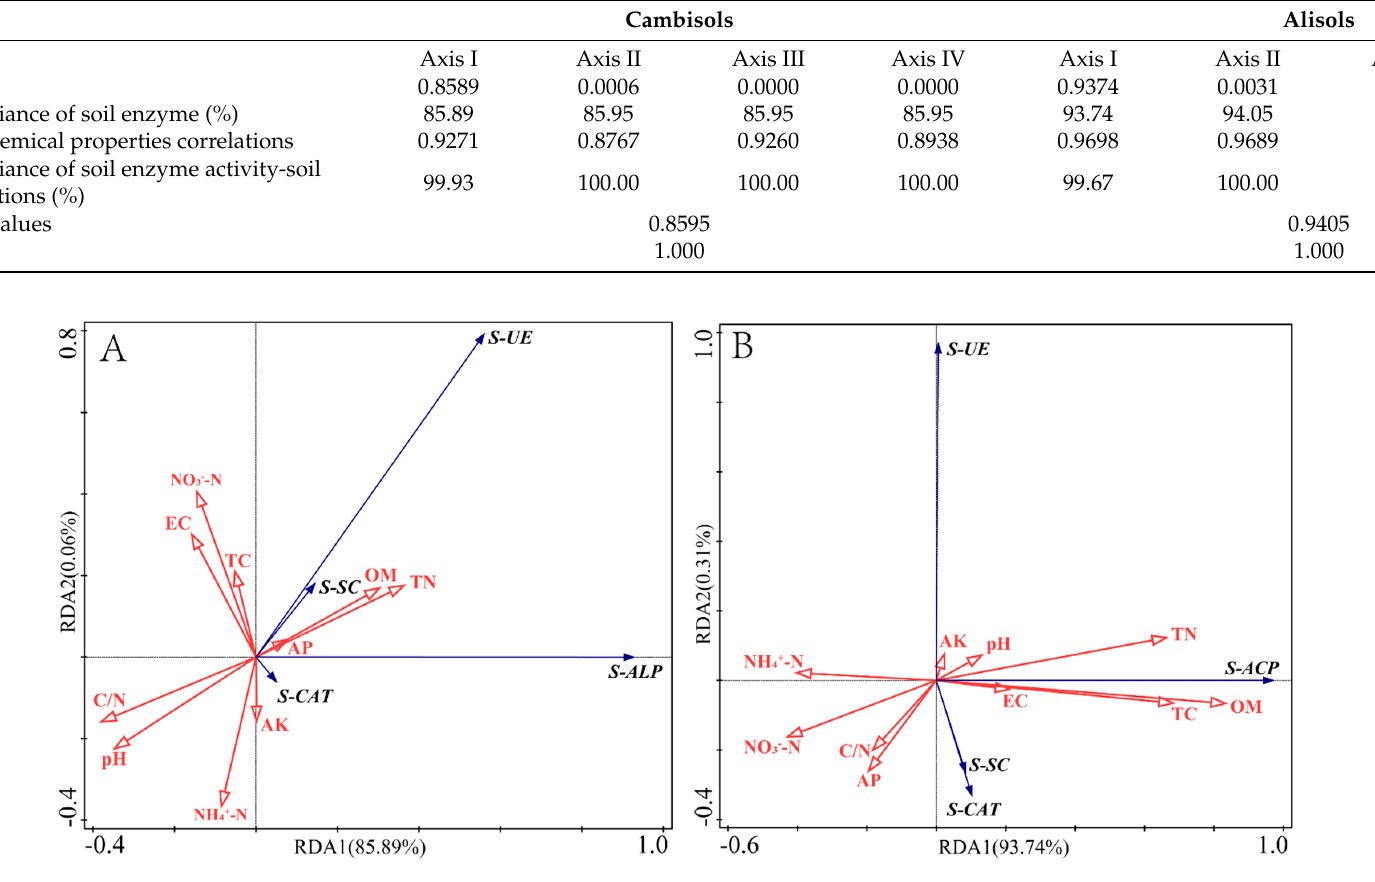
Figure 3. ( A ) is biplot of the first two axes of the RDA for Cambisols’ chemical properties and Cambisols’ enzyme activities; ( B ) is biplot of the first two axes of the RDA for Alisols’ chemical properties and Alisols’ enzyme activities. From the two ‐ dimensional sequence diagram (Figure 3B) of soil enzyme activity and